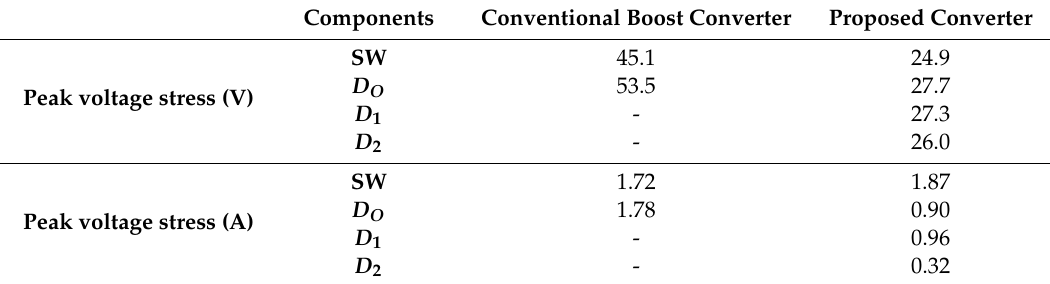
Table 2. Voltage and current stresses of components in the experimental boost converters .